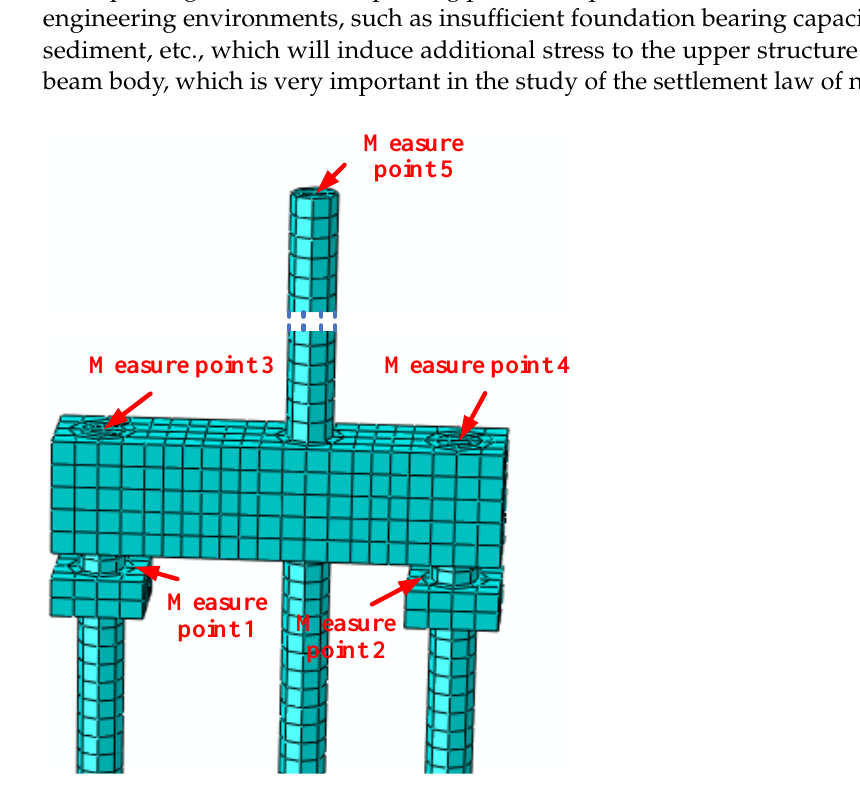
Figure 6. Data extraction points of the numerical model.